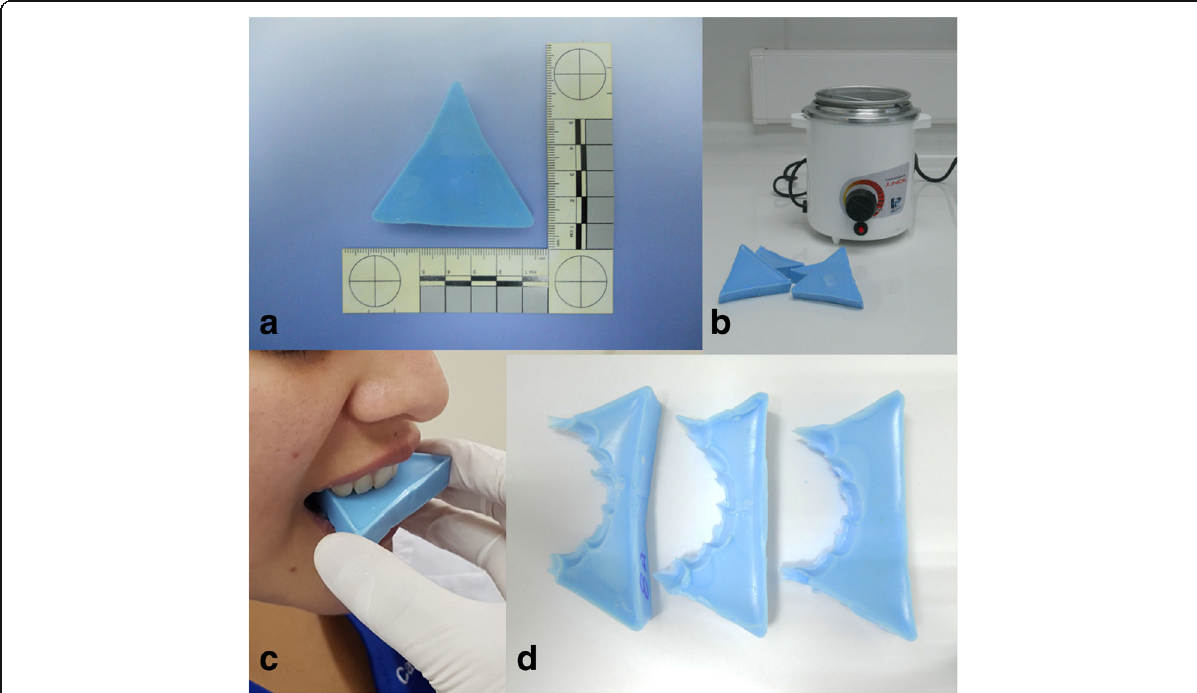
Fig. 1 Protocol for register the test bite records. a Triangular blue wax wafers made Ad-hoc with Great Lakes Tapered Wafers 25/pkg.® (Great Lakes Orthodontics Ltd., Tonawanda NY, USA). b Wax immersion in a thermostatically controlled water bath at 58 °C for 60 s. c The subject was asked to perform three consecutive test bites on respective wafers ensuring a natural interocclusal record. d The wafers were removed in a single movement to avoid deformations and placed in cold